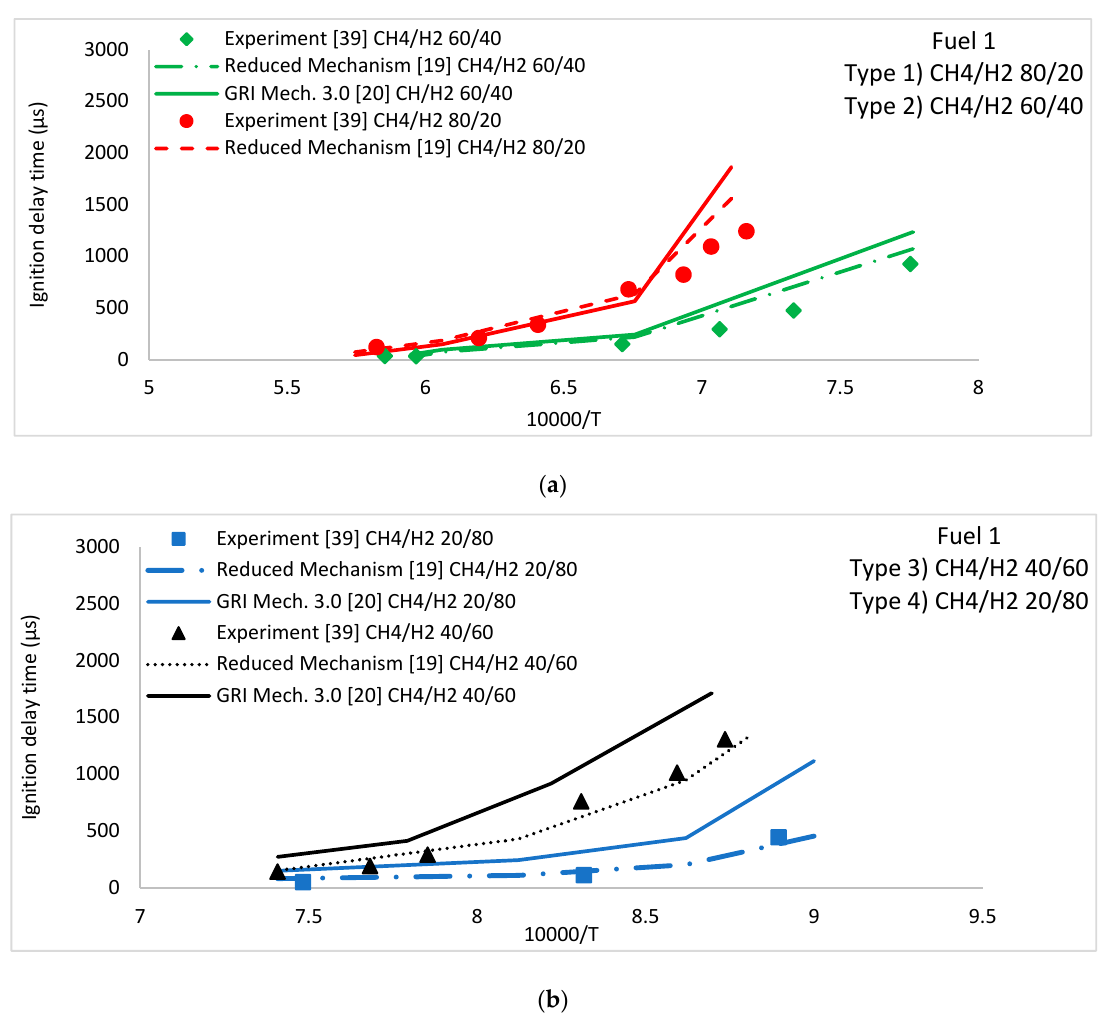
Figure 1. Comparison of the calculated ignition delay time by using the reduced mechanism [19] and GRI Mech. 3.0 [20] and the experimental measurements from Reference [39] for ( a ) Fuel 1 Type 1 and Type 2; and ( b ) Fuel 1 Type 3 and Type 4 at pressure 5 bar and equivalence ratio 0.5.